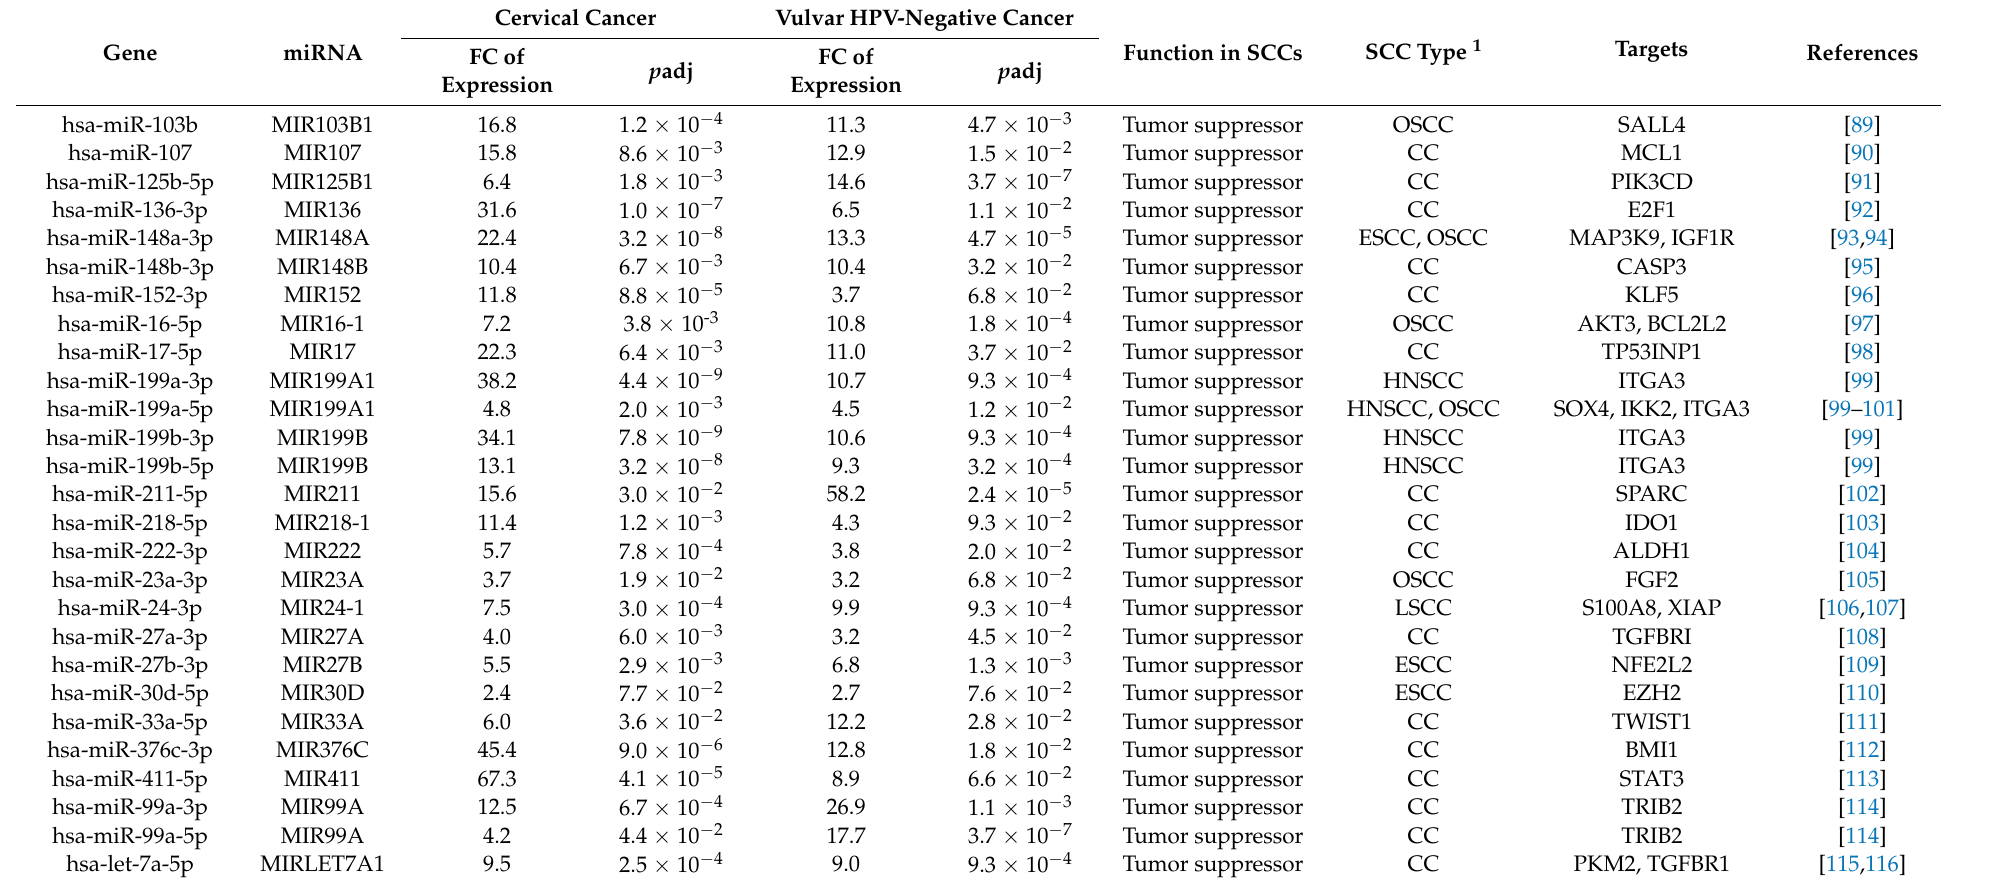
Table 2. MicroRNAs exclusively downregulated in both cervical HPV-positive and vulvar HPV-negative tumors. The designation of individual miRNAs as tumor suppressors or oncogenes is based on their experimentally confirmed characteristics relevant to carcinogenesis (invasiveness, proliferation). Literature mining was aimed primarily at studies on cervical cancers; if none were available, experimental evidence for other types of SCCs was